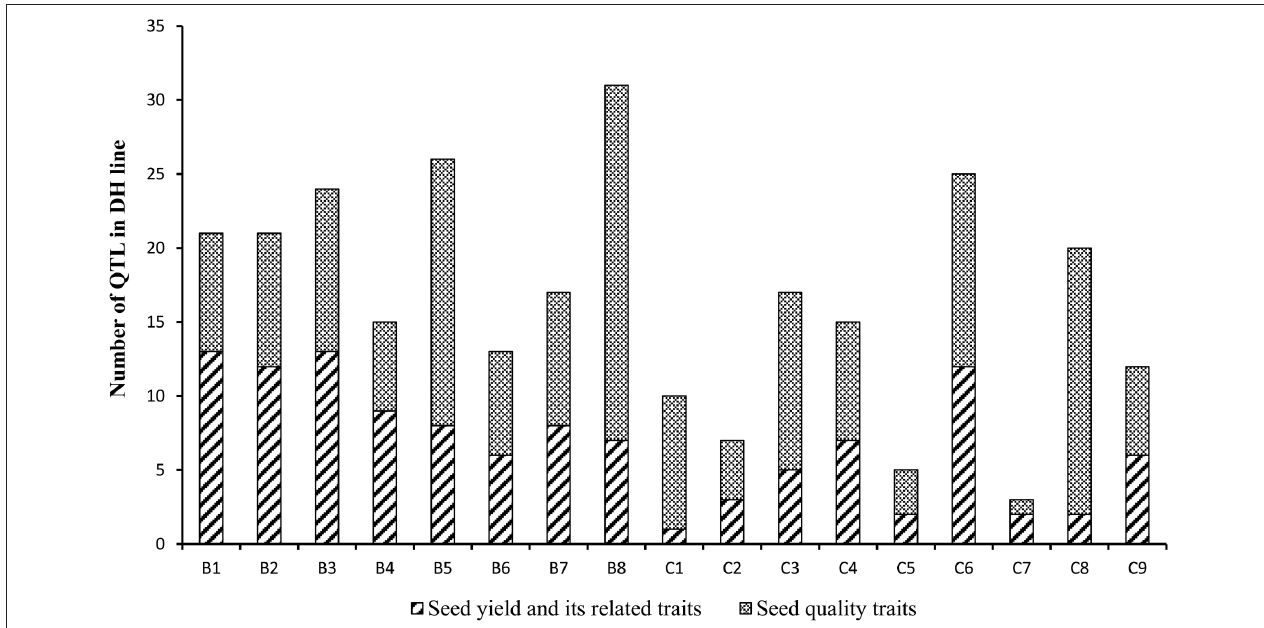
FIGURE 6 | The number of the consensus QTL across the 17 linkage groups of YW DH population. The boxes with diagonal lines and cross lines represent the QTL number for seed yield with its related traits and seed quality traits,